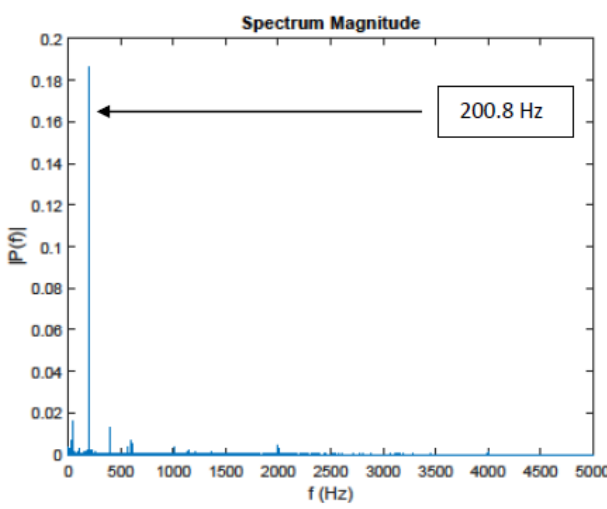
Figure 6. Measurement from microphone (8).